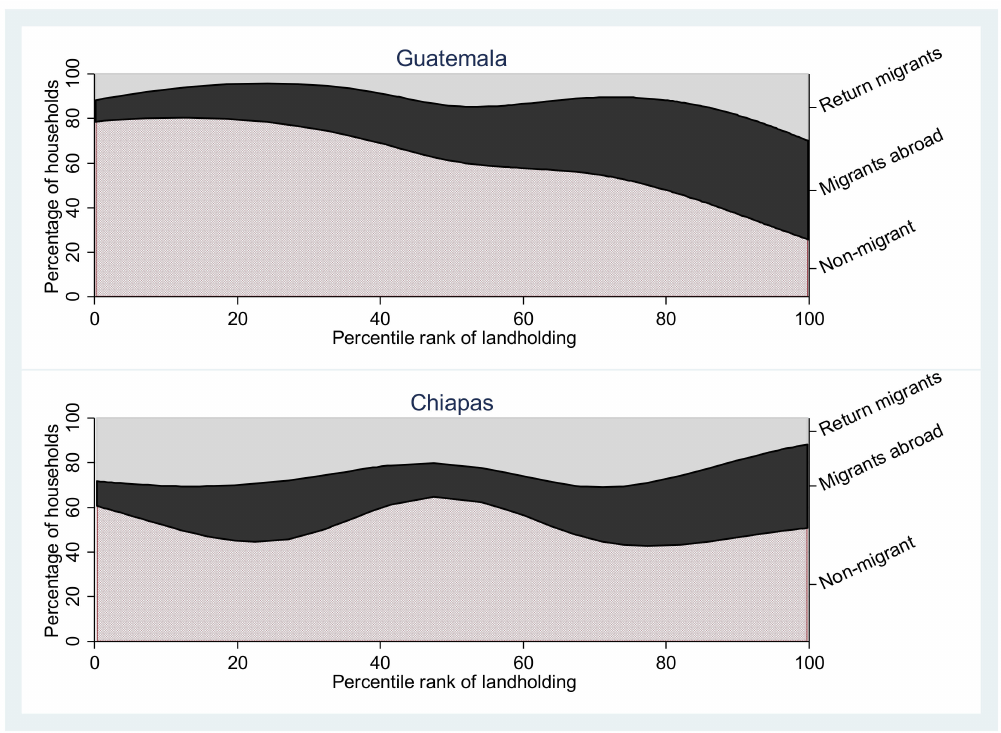
Figure 6. Landholding distribution by migration